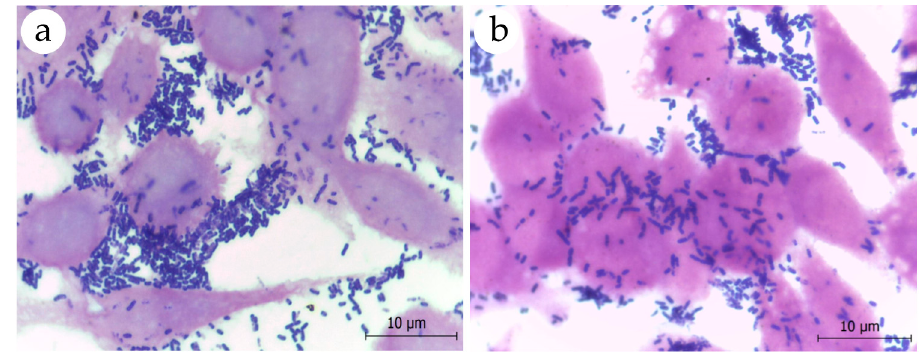
Figure 2. Gram staining of bacterial isolates before ( a–d ) and after ( e–g ) the coaggregation assays of L. plantarum ATCC 8014 with the three species of Clostridium. ( a ) L. plantarum , ( b ) C. butyricum , ( c ) C. difficile, and ( d ) C. perfringens controls. Coaggregation of L. plantarum and ( e ) C. butyricum , ( f ) C. difficile, or ( g ) C. perfringens . Formation of bacterial aggregates were observed after mixing L. plantarum with each Clostridium strain. Gram stained slides were visualized by light microscopy under a 100× oil immersion objective.